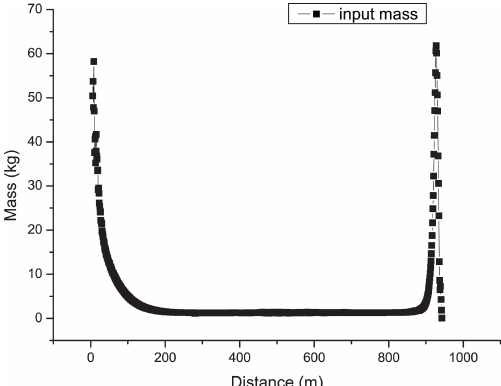
Figure 3. Dissolved salt over each element after 3years of simula- tion with 10m fault thickness.